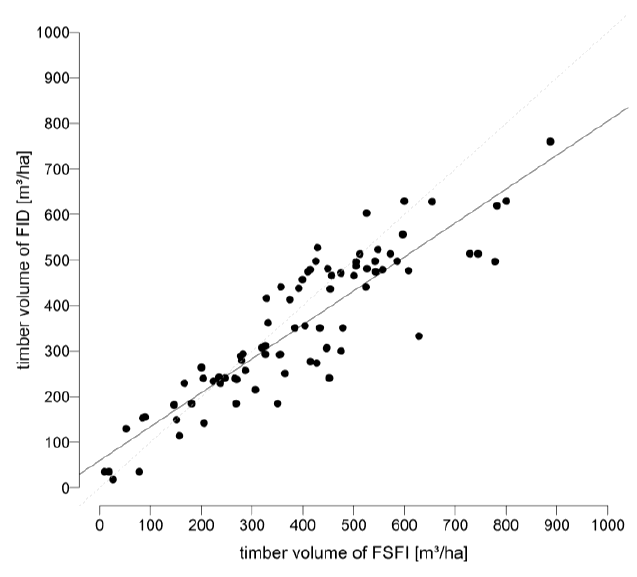
Figure 3. Comparison of timber volume from the plot-based Federal State Forest